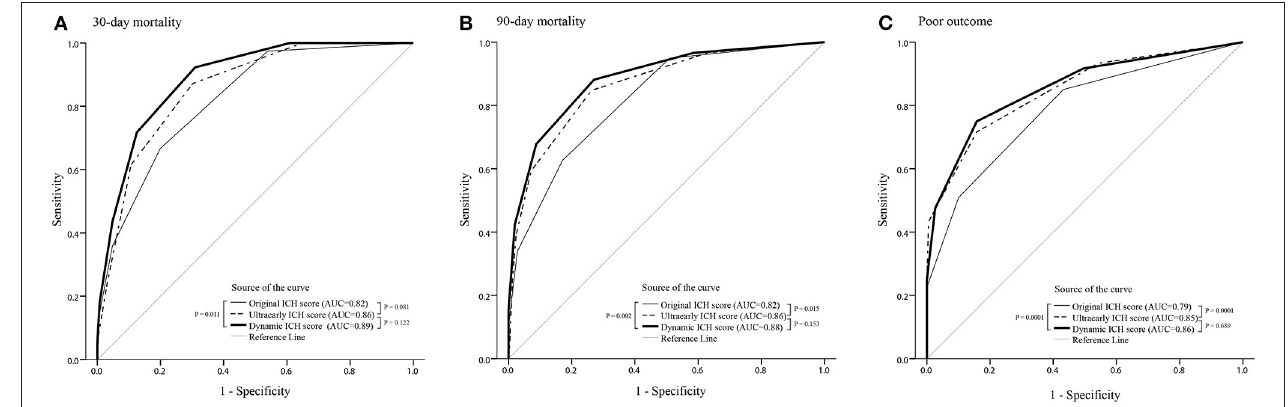
FIGURE 1 | ROC curves of the oICH score, dICH score, and uICH score for prediction of 30-day mortality (A) , 90-day mortality (B) , and poor outcome (C) , respectively. ICH, intracerebral hemorrhage; ROC, receiver operating characteristic; oICH, original intracerebral hemorrhage; dICH, dynamic intracerebral hemorrhage; uICH, ultra-early intracerebral hemorrhage.